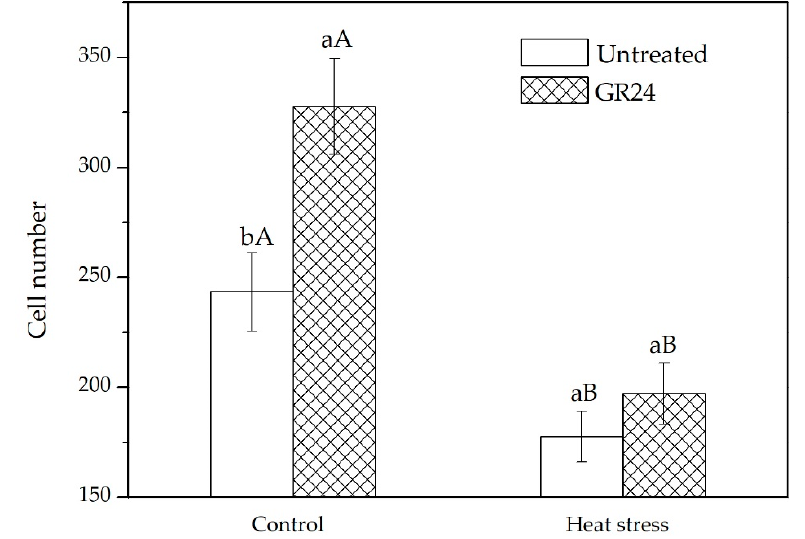
Figure 2. Effects of GR24 on number of leaf cells in the meristematic zone under two different temperature regimes. Each value represents a mean of six to eight leaves for each seedling. Error bars indicate standard deviation. Lowercase letters are for comparison between GR24-treated and untreated plants, and uppercase letters are for comparison between treatments under two different temperature regimes.